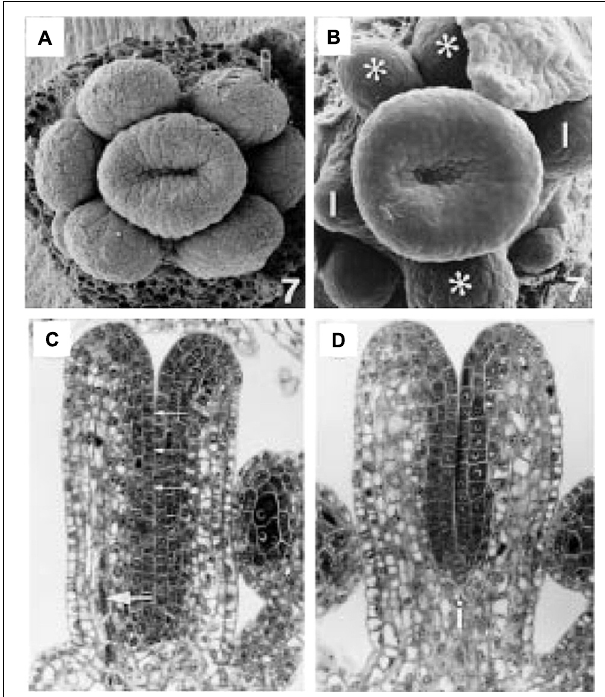
FIGURE 5 | Early stage wild type and ett-1 gynoecium development. (A) Stage 7 wild type floral meristem showing upward growth of the gynoecial tube. (B) Stage 7 ett-1 floral meristem showing a shallower gynoeciual tube. Aberrant stamen is marked with *. Scale bar is 22 μ M (A) and 30 μ m (B) , respectively. (C) Section of the medial plane of a stage 8 wild type gynoecium showing inner surface (small arrows) and medial vascular bundle (large arrow). (D) Section in the medial plane of a stage 8 ett-1 gynoecium showing a shorter tube.The basal gynophore (i) is more prominent. Images reproduced from Sessions (1997) with permission from American Journal of Botany